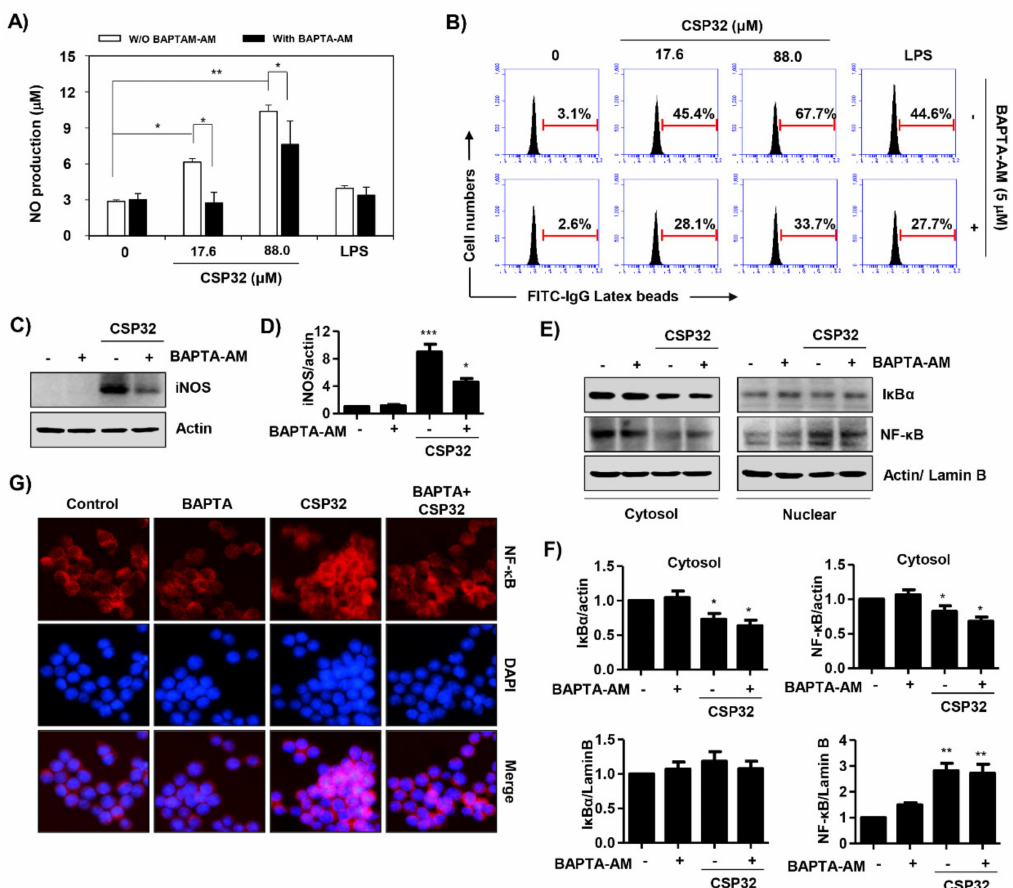
Figure 6. Ca 2 + regulated CSP32-mediated M1 polarization. ( A – C ) Cells were pretreated with or without 5 µ M BAPTA-AM for 30 min and then incubated with the indicated concentrations of CSP32 and LPS for 24 h. ( A ) The amount of NO in the cell supernatants was measured using Griess reagents. Data are expressed as the mean ± SD ( n = 4). * p < 0.05 and ** p < 0.01 compared between the groups. ( B ) Representative flow cytometric histogram of the phagocytosis capacity using fluorescent FITC-IgG latex beads. ( C ) Protein expression of iNOS. β -actin was used as an internal control for total cell lysates. ( D ) Quantitative analysis of iNOS expression that was indicated as a fold change relative to the control. Data are expressed as the mean ± SD ( n = 3). * p < 0.05 and *** p < 0.001 compared with the control. ( E , F ) Cells were pretreated with or without 5 µ M BAPTA-AM for 30 min and then incubated with the indicated concentration of 5 µ g / mL CSP32 for 1 h. ( E ) Cytoplasmic and nuclear lysates were examined by western blotting for I κ B- α and NF- κ B. Actin and lamin B1 serve as the internal controls for the cytoplasmic and nuclear lysates, respectively. ( F ) Quantitative analysis of I κ B α and NF- κ B p65 expression that was indicated as a fold change relative to the control. Data are expressed as the mean ± SD ( n = 3). * p < 0.05 and ** p < 0.01 compared with the control. ( G ) Localization of NF- κ B p65 (green) was visualized with fluorescence microscopy. Cells were stained with DAPI for visualization of the nuclei